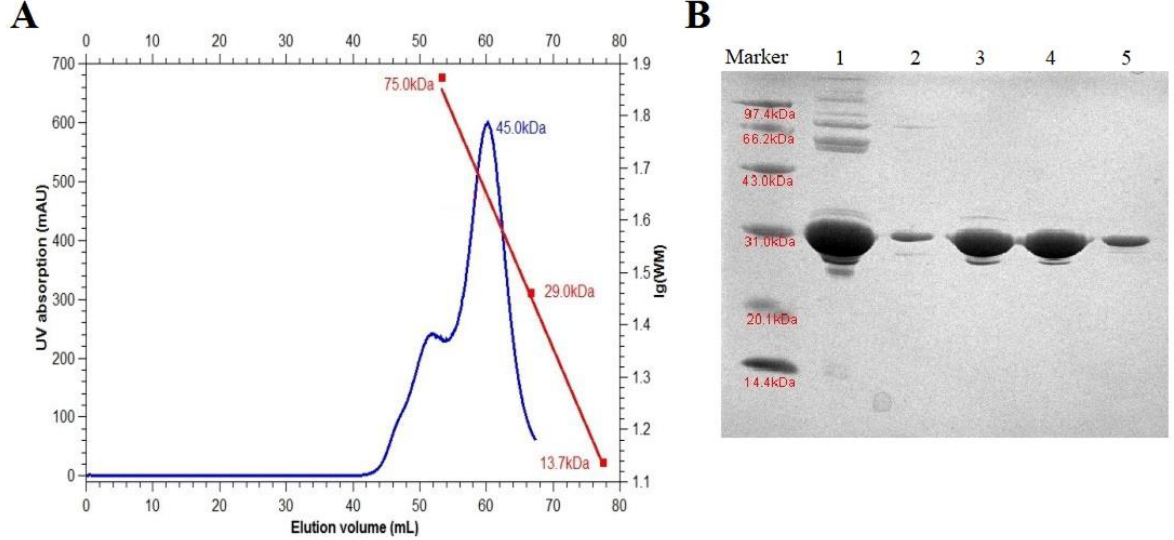
Figure 2. Protein purification of MMACHC: ( A ) Gel-filtration chromatography of MMACHC; ( B ) 15% SDS – PAGE analysis of recombinant MMACHC recovered from induced Escherichia coli cells. The SDS – PAGE was stained with Coomassie blue R-250. Lane M, molecular weight marker; lanes 1, purified recombinant MMACHC before gel filtration; lanes 2 to 5 denote further purified MMACHC by gel filtration.